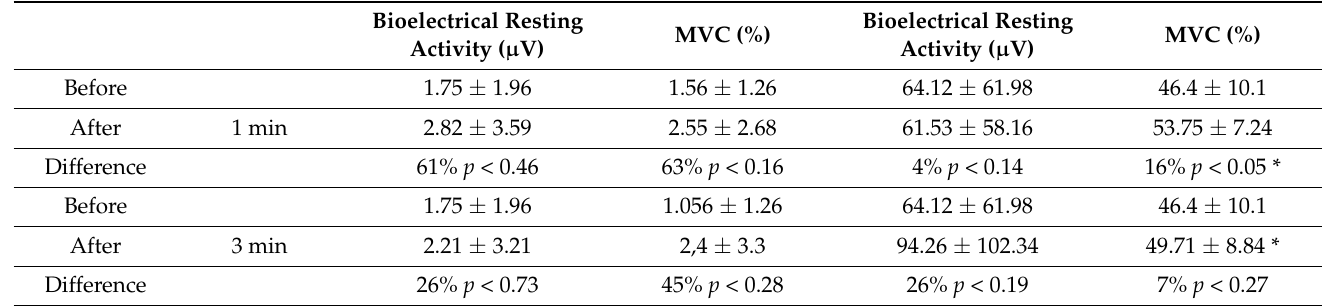
Table 2. The mean values and standard deviation of bioelectrical activity of the rectus femoris before whole-body cryotherapy and after 3 min of whole-body cryotherapy.